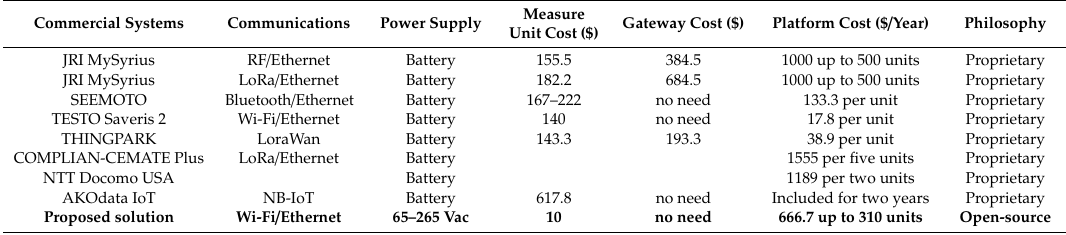
Table 9. Features of commercial solutions versus research